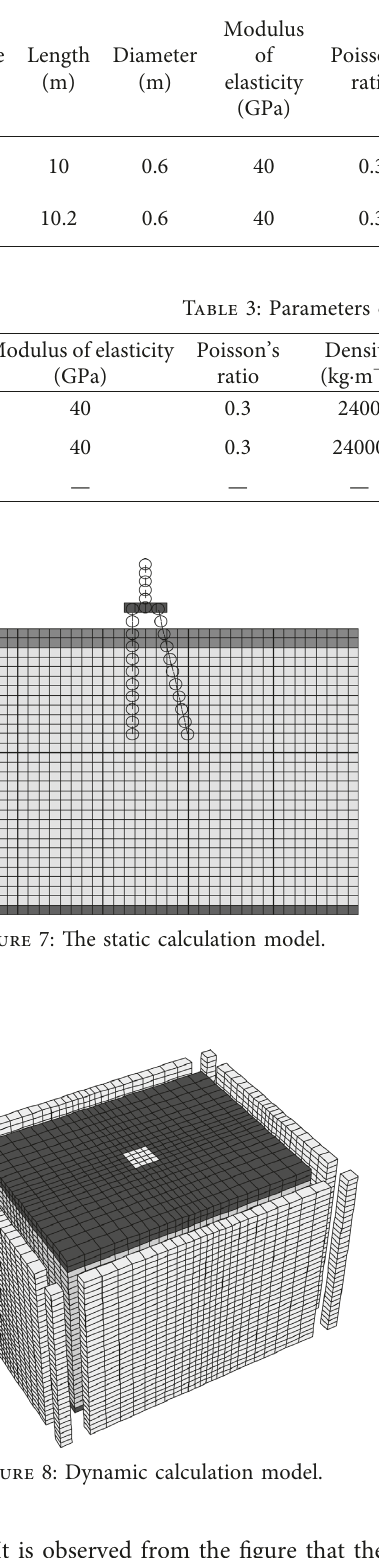
Table 2: Parameters of the pile element.